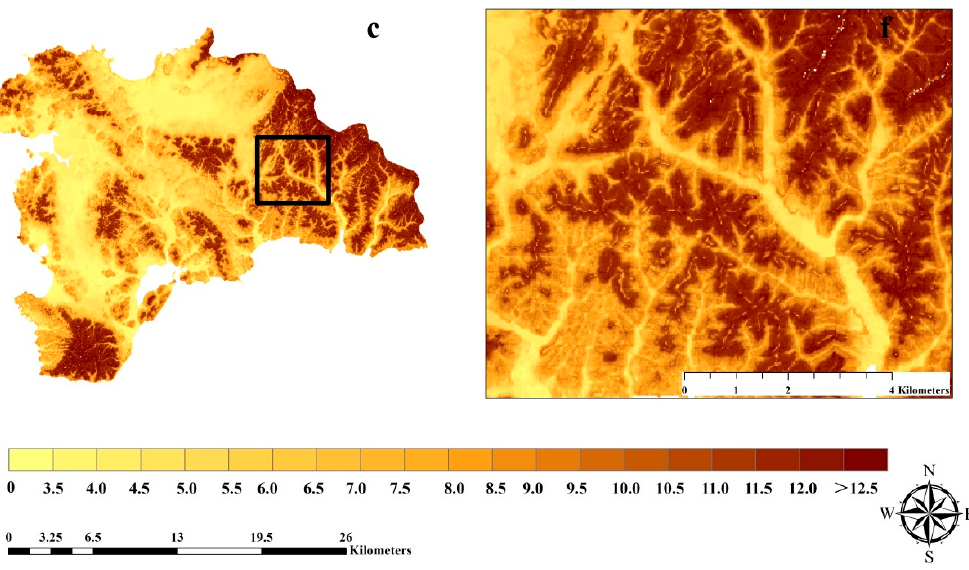
Figure 7. Distribution maps of topsoil (0–30cm) organic carbon stocks (kg m − 2 ) derived from three boosted regression tree (BRT) models. ( a ) full variables model (Model A); ( b ) topography and climate variables (Model B); and ( c ) only multispectral remote sensing variables (Model C); ( d – f ) areas covered with black boxes are detailed on the right.